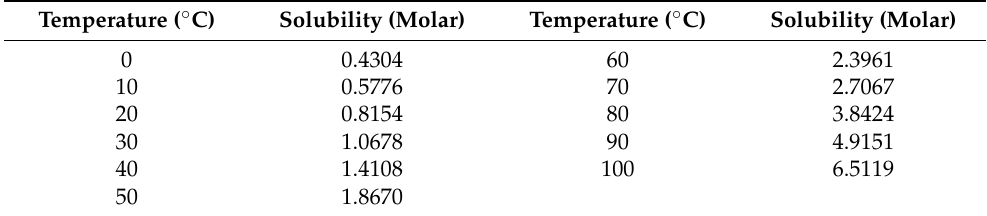
Figure 2. Distribution of boron species in aqueous solutions at different pH levels. ( a ) [B] 0 = 0.01 M. ( b ) [B] 0 = 0.4 M. Table 2. Solubility of boric acid in water at various temperatures (Adapted with permission from Ref. [16]. 2013, Elsevier).